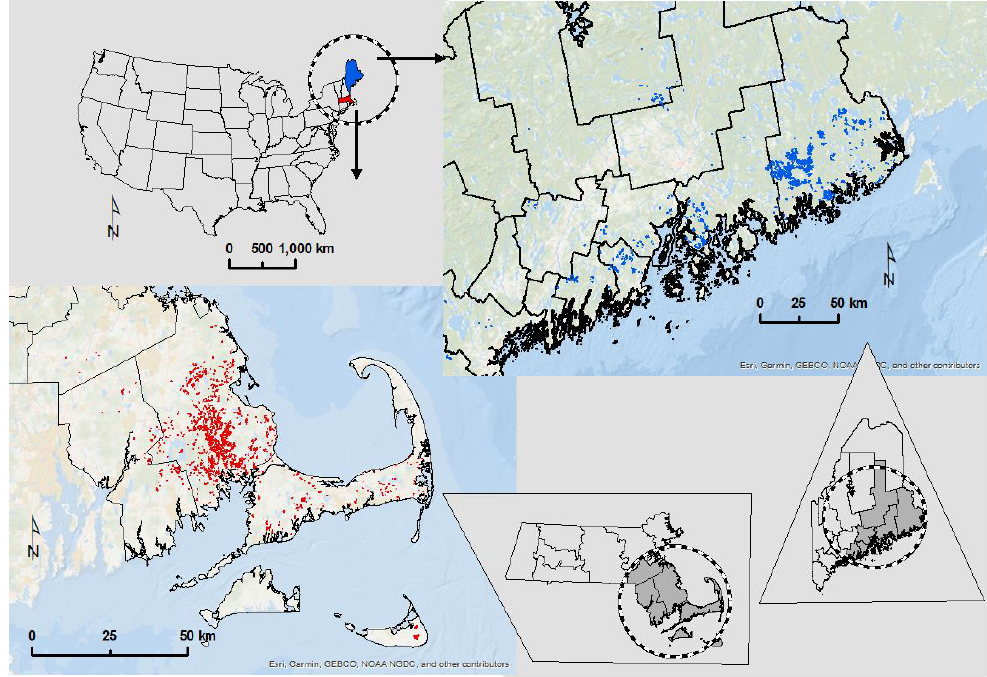
Figure 1. Production areas and regions for Massachusetts, United States (USA) cranberries (red) and Maine, USA, wild blueberries (blue).